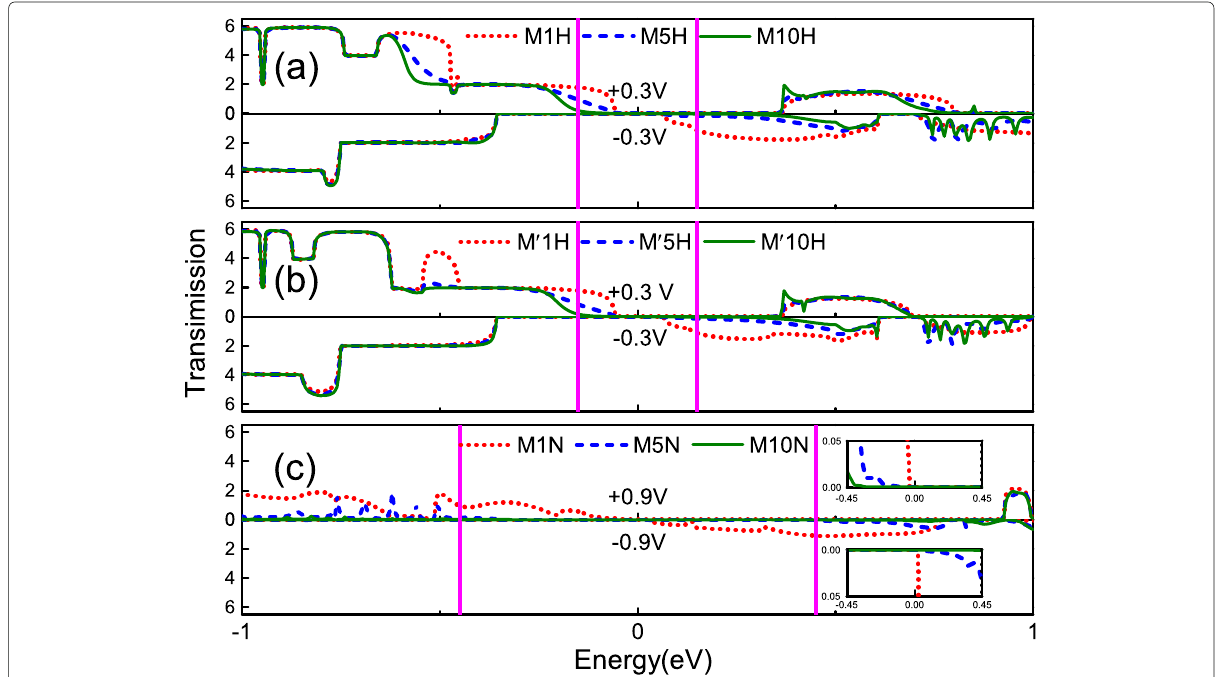
Fig. 5 The transmission spectra for heterojunctions a M n H at a bias ± 0.3 V, b M (cid:2) n H at a bias ± 0.3 V, and c M n N at a bias ± 0.9 V with the same choice of n in line colors for Fig. 4, where in each figure the upper/lower part for the transmission at the positive/negative bias. The two vertical (magenta) solid lines indicate the bias window. The inset in Fig. 5c is an amplification of the transmission spectra in the bias